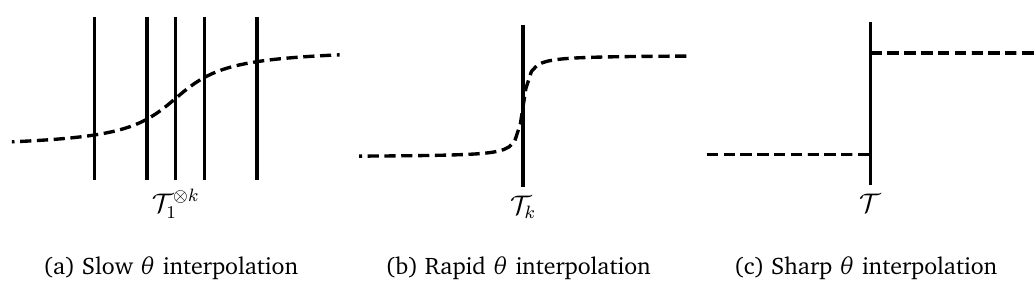
Figure 1: The interfaces for different profiles of θ that interpolate from θ = θ θ = θ + 2 π k . The dashed lines are the profile of the θ parameter and the solid 0 lines are the locations of the interfaces. In (a), there are k domain walls located